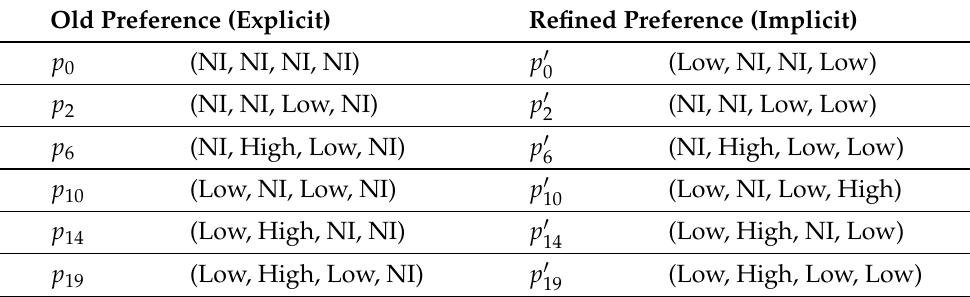
Table 2. Explicit preference (before) and implicit preferences